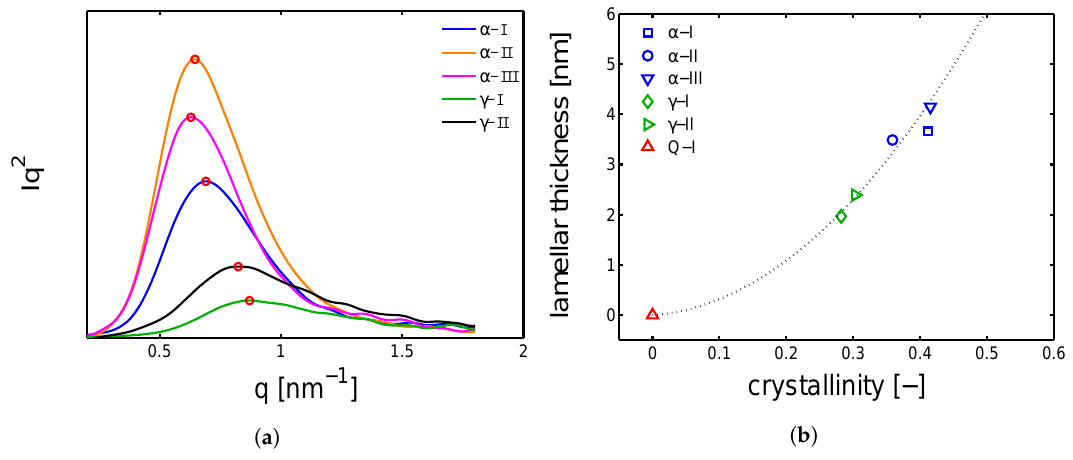
Figure 3. ( a ) small angle X-ray scattering integrated patterns in dry conditions; ( b ) lamellar thickness as a function of crystallinity in dry state. The dashed line is a guide to the